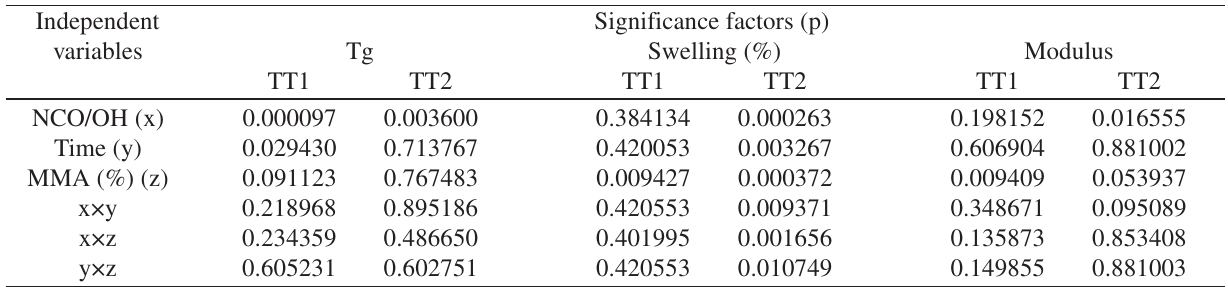
Table 3. Significance factors (p) for the dependent variables Tg and swelling and Modulus for both cure thermal treatment (TT1 an TT2).